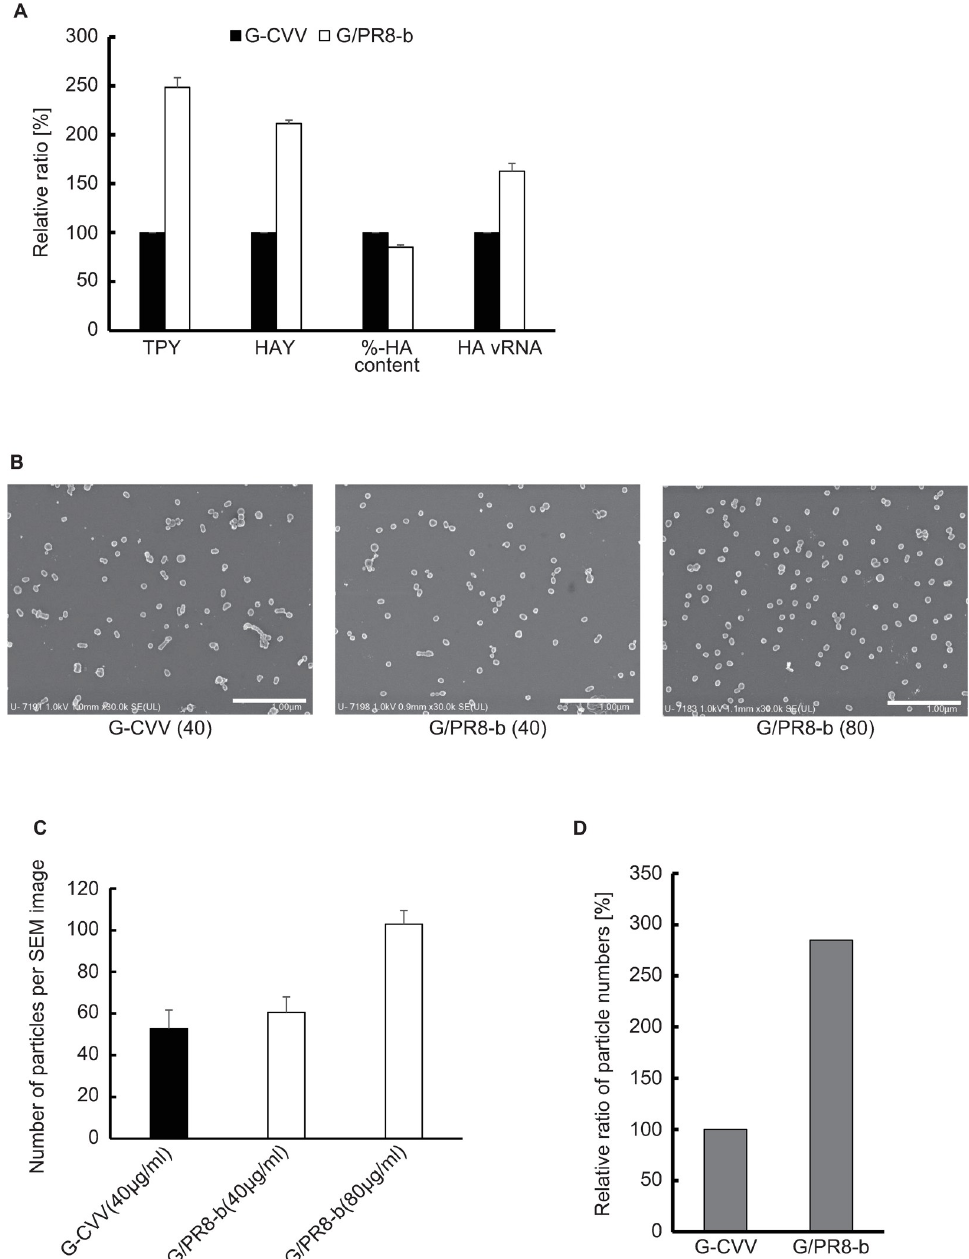
Fig 5. Characterization of master virus mutants. (A) Relative ratios of the total protein yield (TPY), HA antigen yield (HAY), %-HA content, and HA vRNA content between G-CVV and G/PR8-b. The values are presented as the mean values with standard deviations from three independent experiments. (B) Scanning electron micrographs of viral particles. Representative electron micrographs of G-CVV and G/PR8-b are shown. The protein concentrations of each sample, 40 μ g/ml and 80 μ g/ml, are shown as (40) and (80). The scale bars indicate 1 μ m. (C) Average number of particles per field of view obtained for G-CVV and G/PR8-b. Average numbers were calculated from 20 fields of view. (D) Relative ratio of viral particle numbers in allantoic fluid obtained for G-CVV and G/PR8-b. The values are presented as the mean values with standard deviations from three independent experiments.